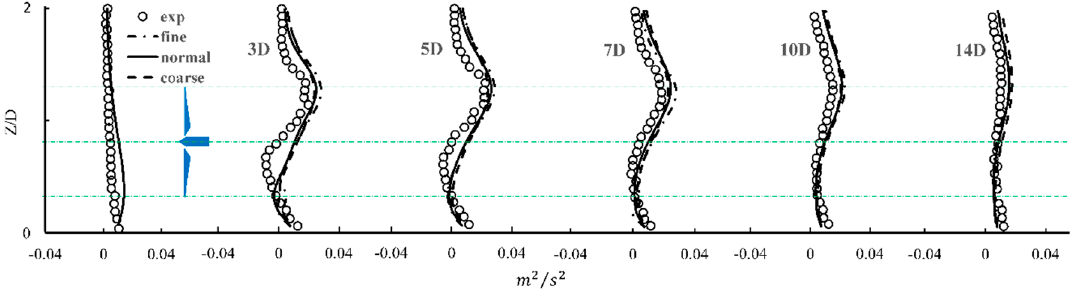
Figure 20. Vertical distribution of stream ‐ wise turbulence intensity simulated by different mesh schemes. Energies 2016 , 9 , 784 15 of 17